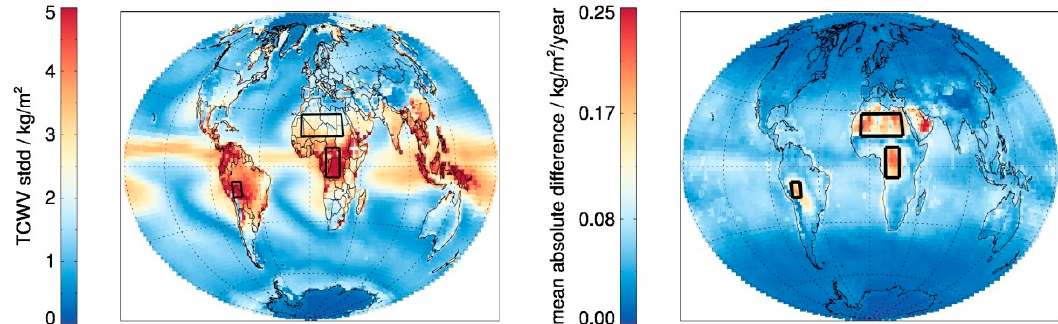
Figure 2. Spatial maps of standard deviation ( left ) and mean absolute differences in trend estimates ( right , updated from [35]. Both panels have been computed using all eleven TCWV data records covering the period 1988–2008. The black boxes mark the regions of central Africa, Sahara and South